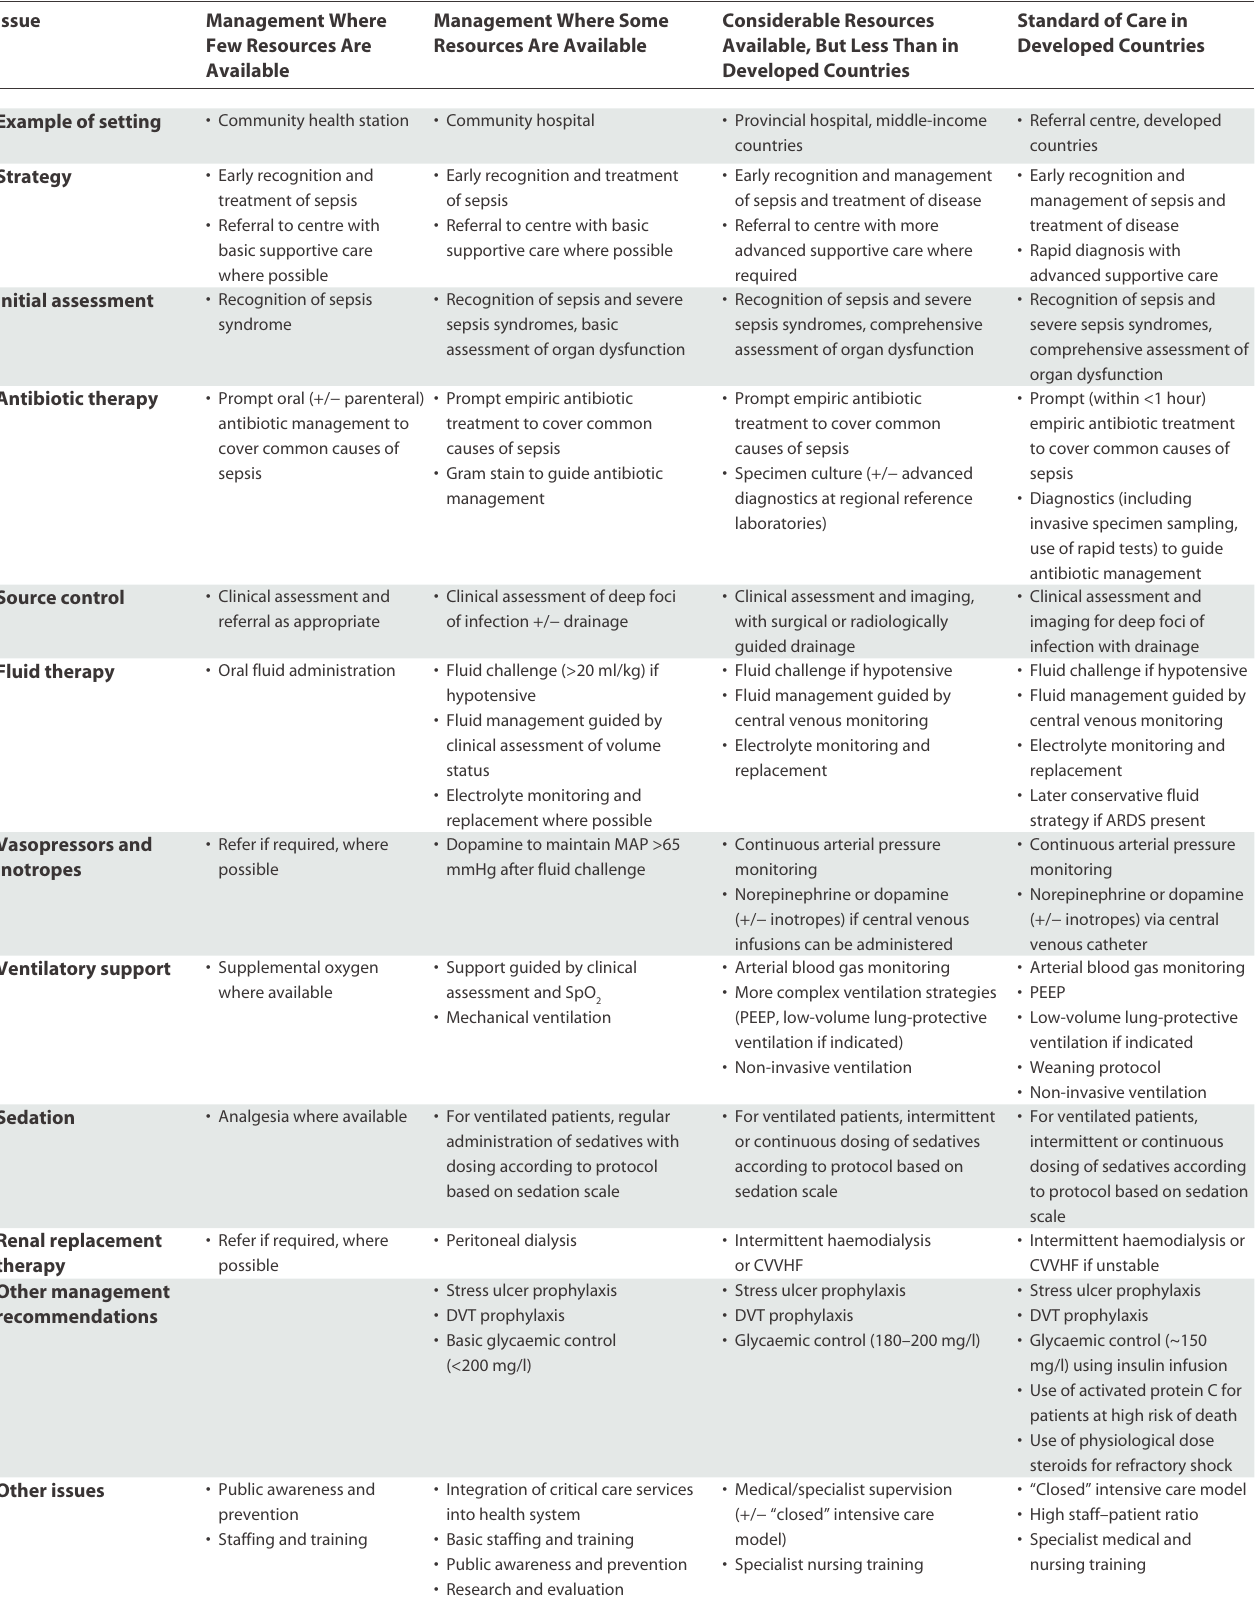
Table 1. Possible Interventions for the Management of Sepsis in Resource-Constrained